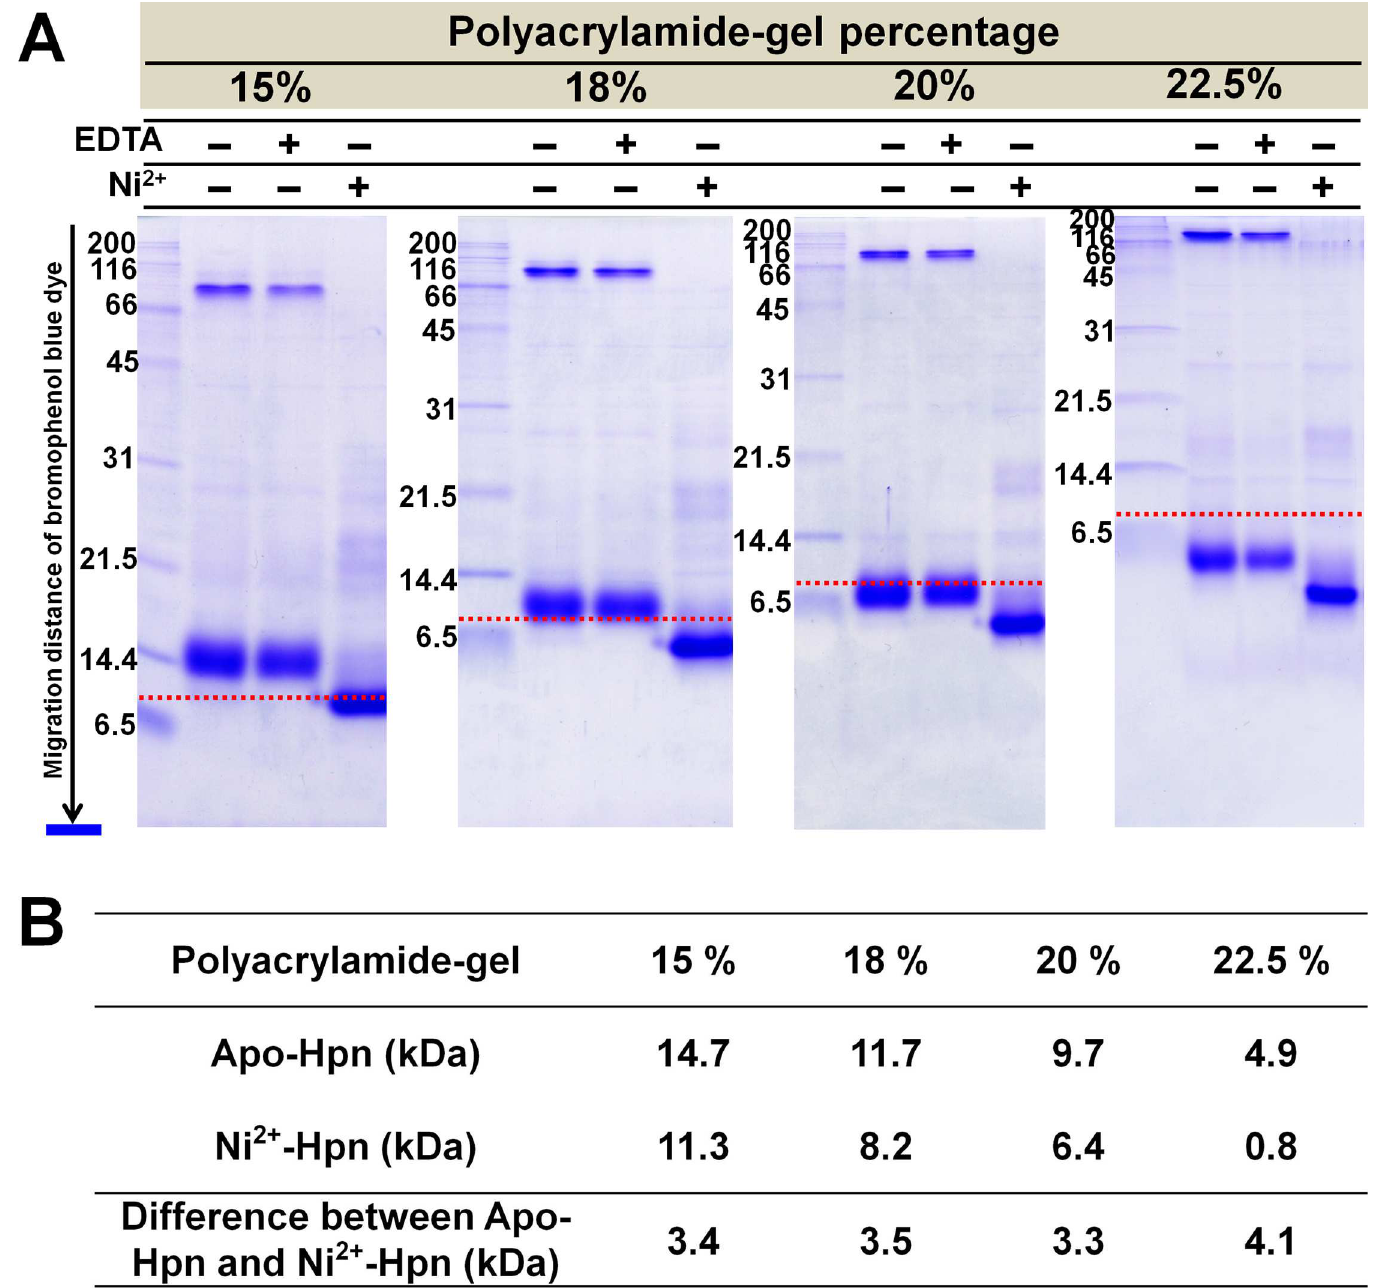
Fig 4. Effect of polyacrylamide-gel concentration on migration speed of recombinant Hpn without or with metal-treatment on SDS-PAGE. A. Relativepositionof apo- and Ni 2+ -treated Hpn protein depending on the polyacrylamide percentage (15, 18, 20 and 22.5%) in gels. Lane M is marker proteins standardfrom NacalaiTesque (200, 116, 66, 45, 31, 21.5, 14.4, 6.5 kDa from top to bottom respectively). The SDS-gel electrophoresis was done till bromophenol blue dye reachedto the bottom in all gels. Therefore, theoretical MW values for marker proteins- lysozyme (14.4 kDa) and Trypsin inhibitor(21.5 kDa) were taken into consideration for estimationof apparentMW using ImageJ software ( protocol provided in Supplementary information as Annexure A ). Red dotted line depicts expectedposition corresponding to theoreticalMW (~6.9 kDa). B. The apparentMW of apo- and Ni 2+ -treated Hpn separatedon different polyacrylamide-gel concentrations was estimated by comparingrelativemigrationdistanceof Hpn with globularmarker proteins on SDS-PAGE.